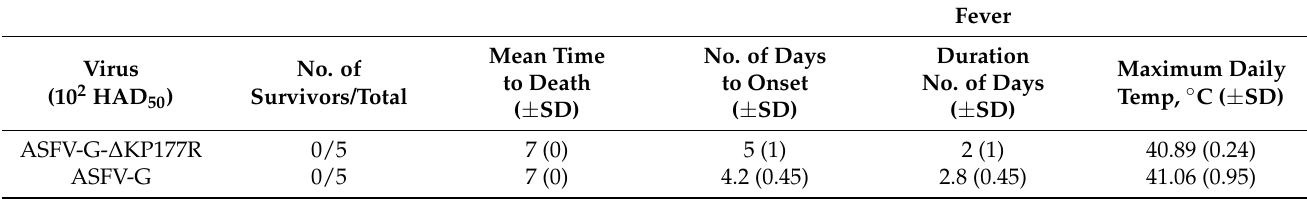
Table 1. Swine survival and fever response following infection with ASFV-G- ∆ KP177R and parental ASFV-G.